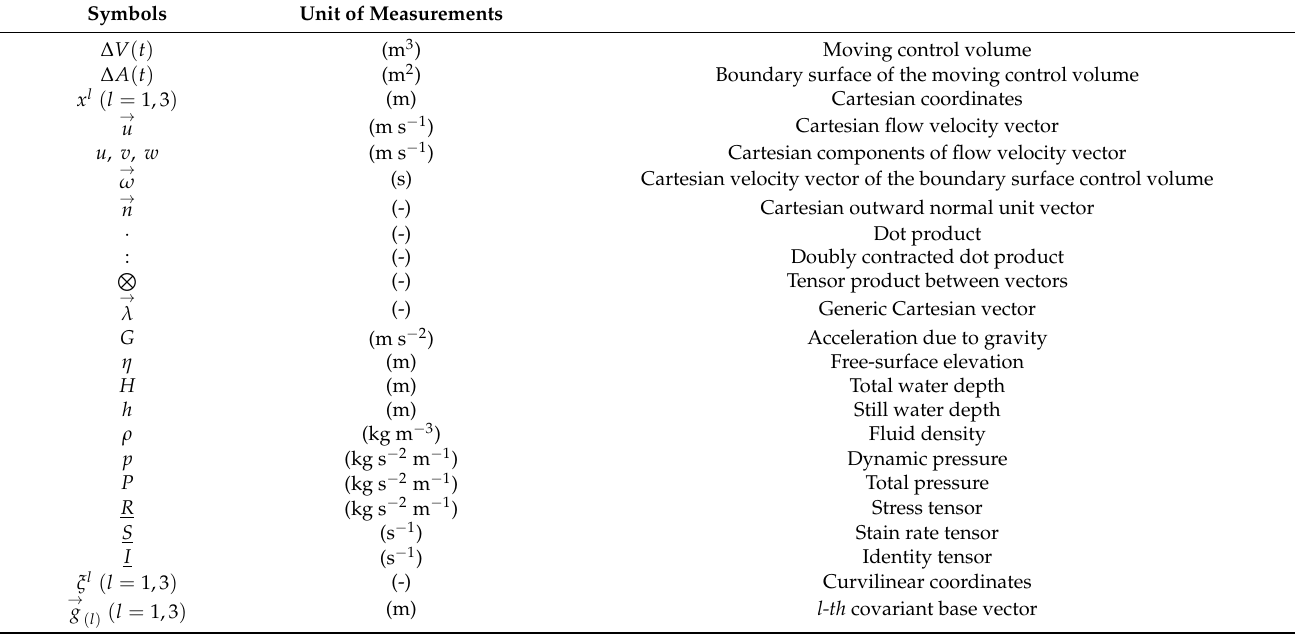
Table A1. Symbols used in this paper.